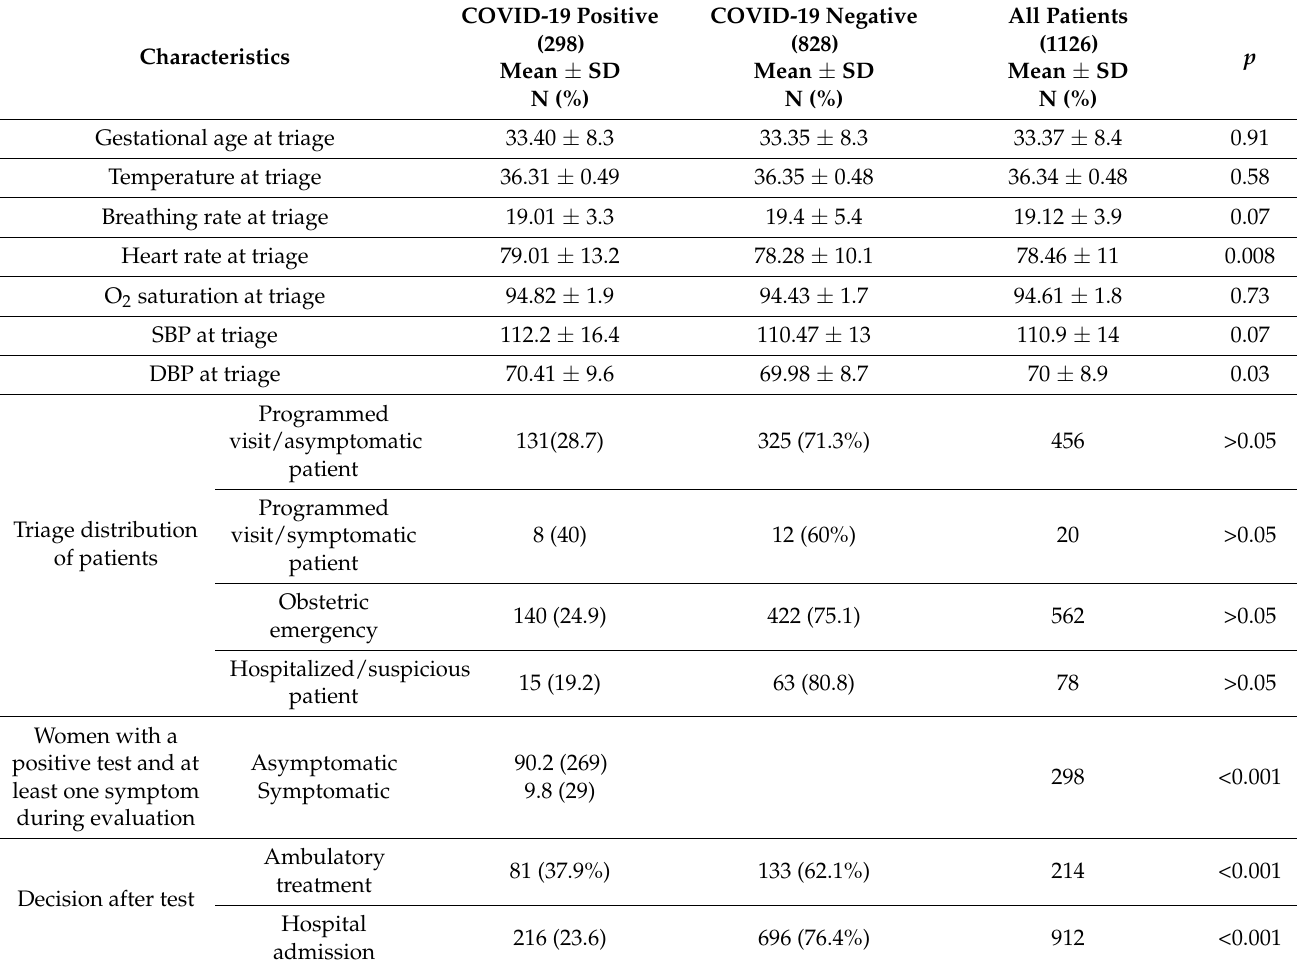
Table 2. Clinical characteristics at